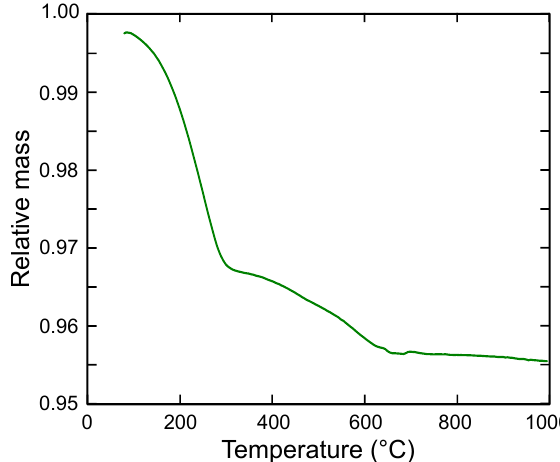
Figure 8: Relative mass as a function of temperature for Mt. Epomeo Green Tu ff